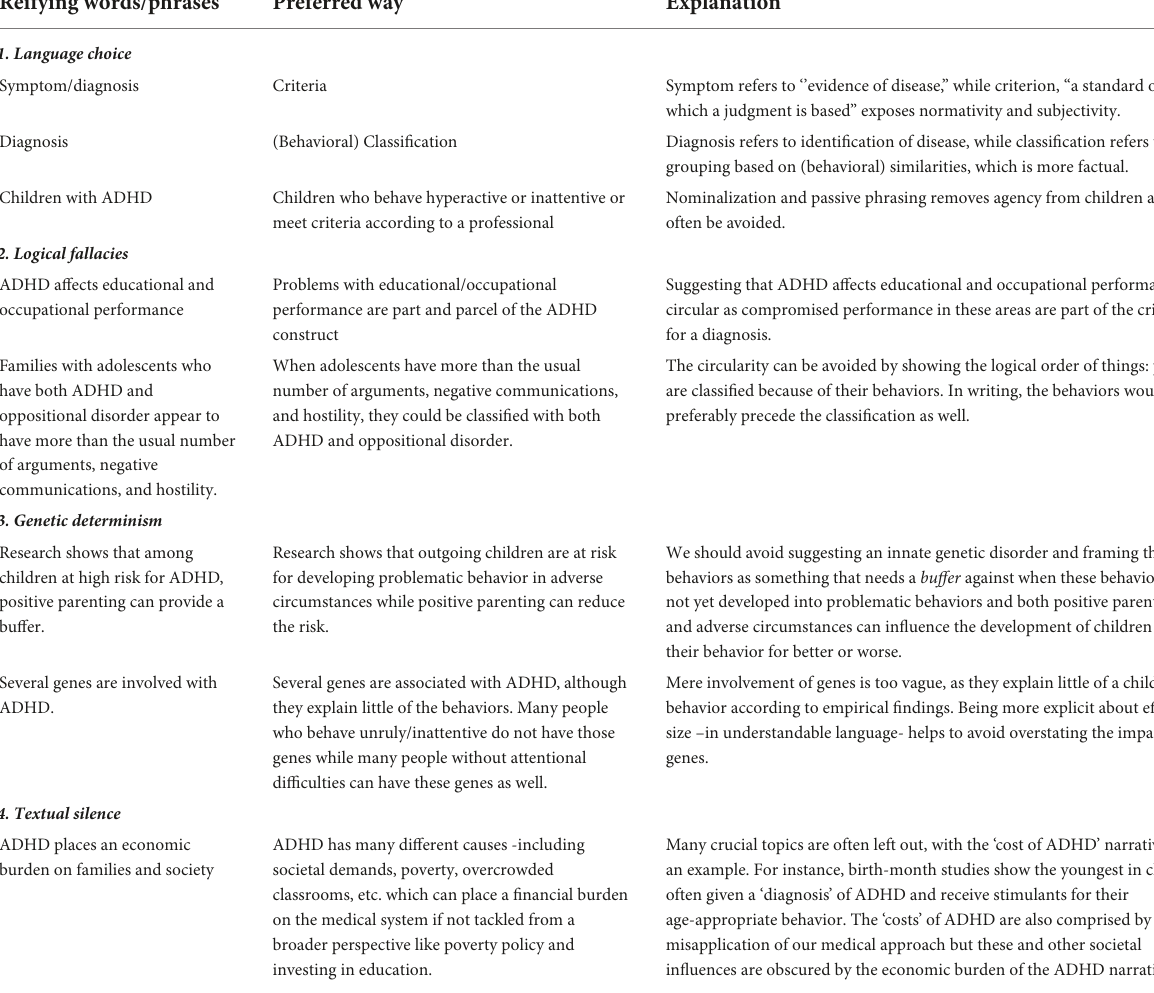
TABLE 1 Examples of four categories of